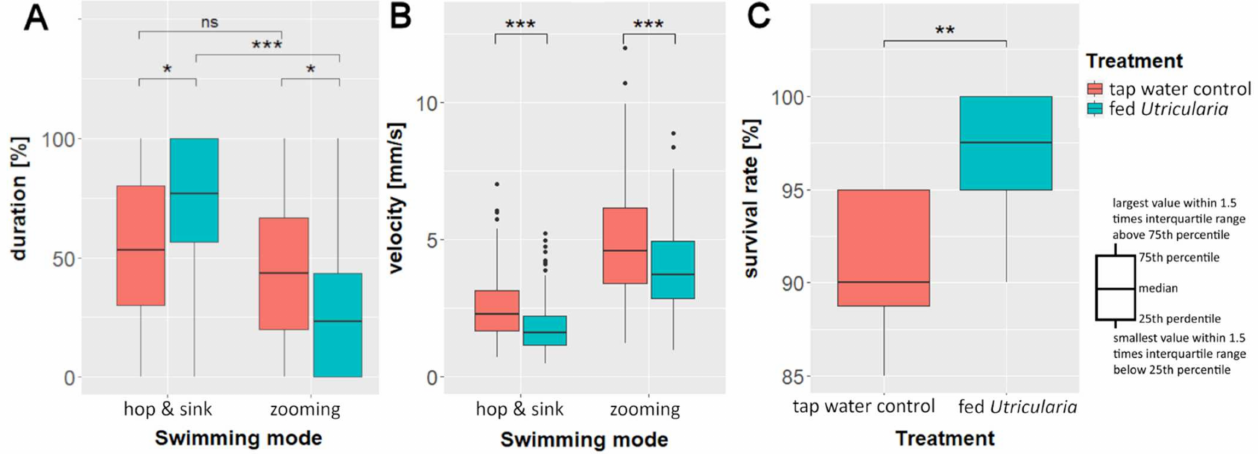
Figure 5. Behavioral changes in C. dubia as response to the presence of U. x neglecta : average duration ( A ) and velocity ( B ) of the two observed swimming modes in the ‘swimming modes’ experiments. ( C ) Survival rate of 20 five-day-old C. dubia (either control or Utricularia -exposed) over 24 h in the presence of 30 U. x neglecta traps. * p < 0.05; ** p < 0.01; *** p <